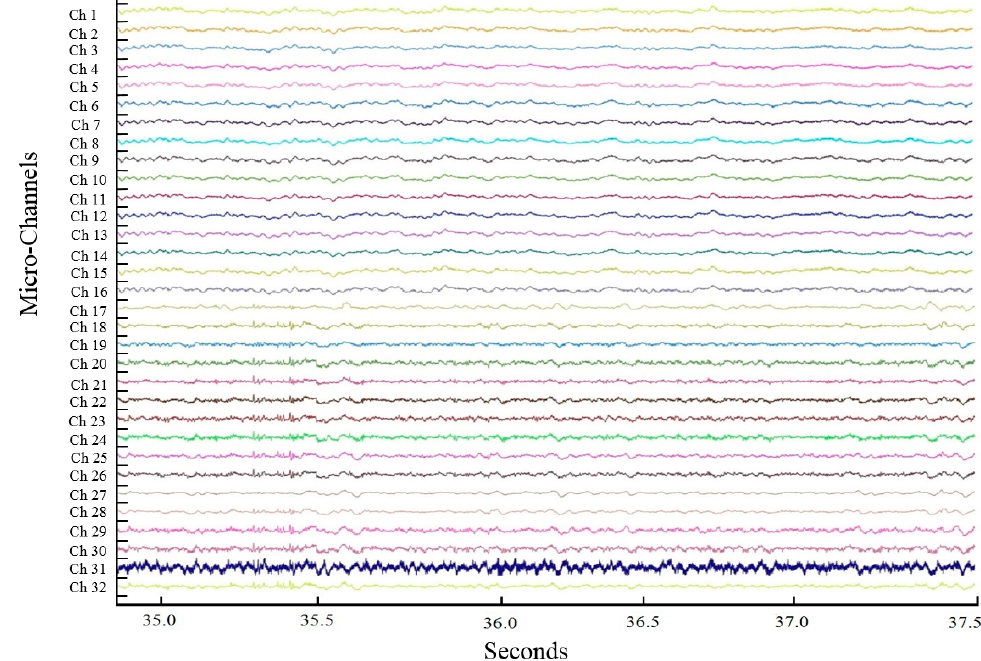
Figure 6. ECoG signals from 32-channel microwires. Each different color signal represents a different signal acquired from a different electrode of the ECoG electrodes.